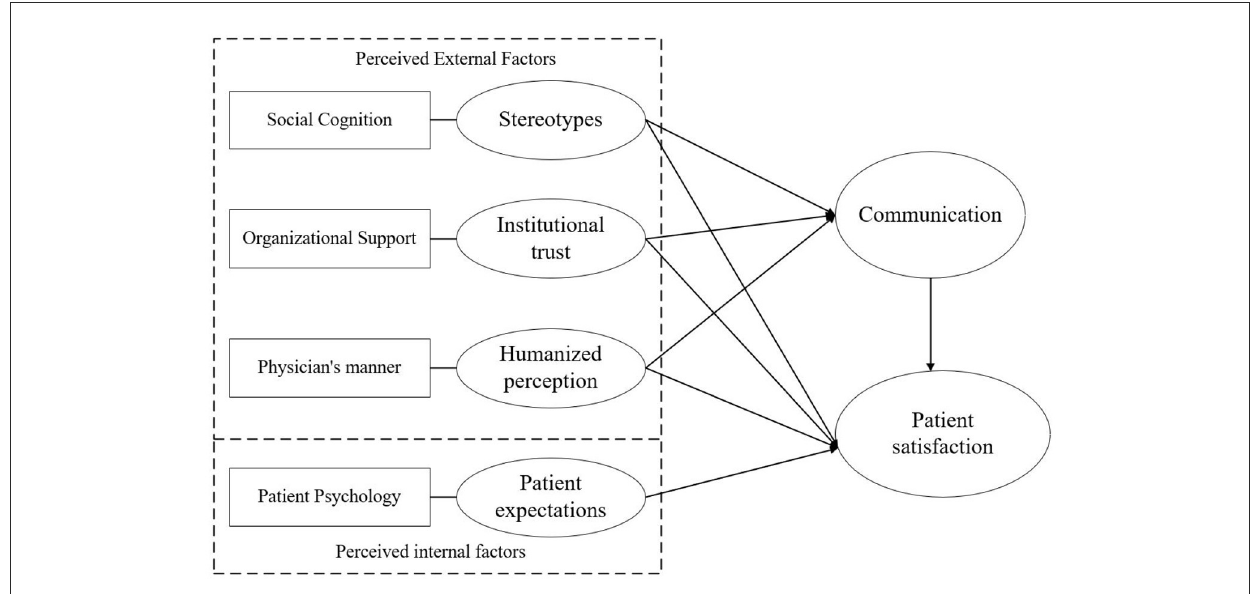
FIGURE1 A psychosocial factor model of patient